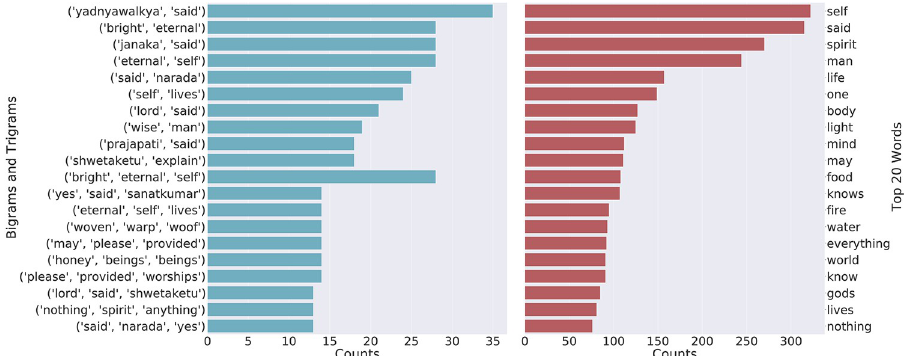
Fig 4. Leading bigrams and trigrams for the Ten Principal